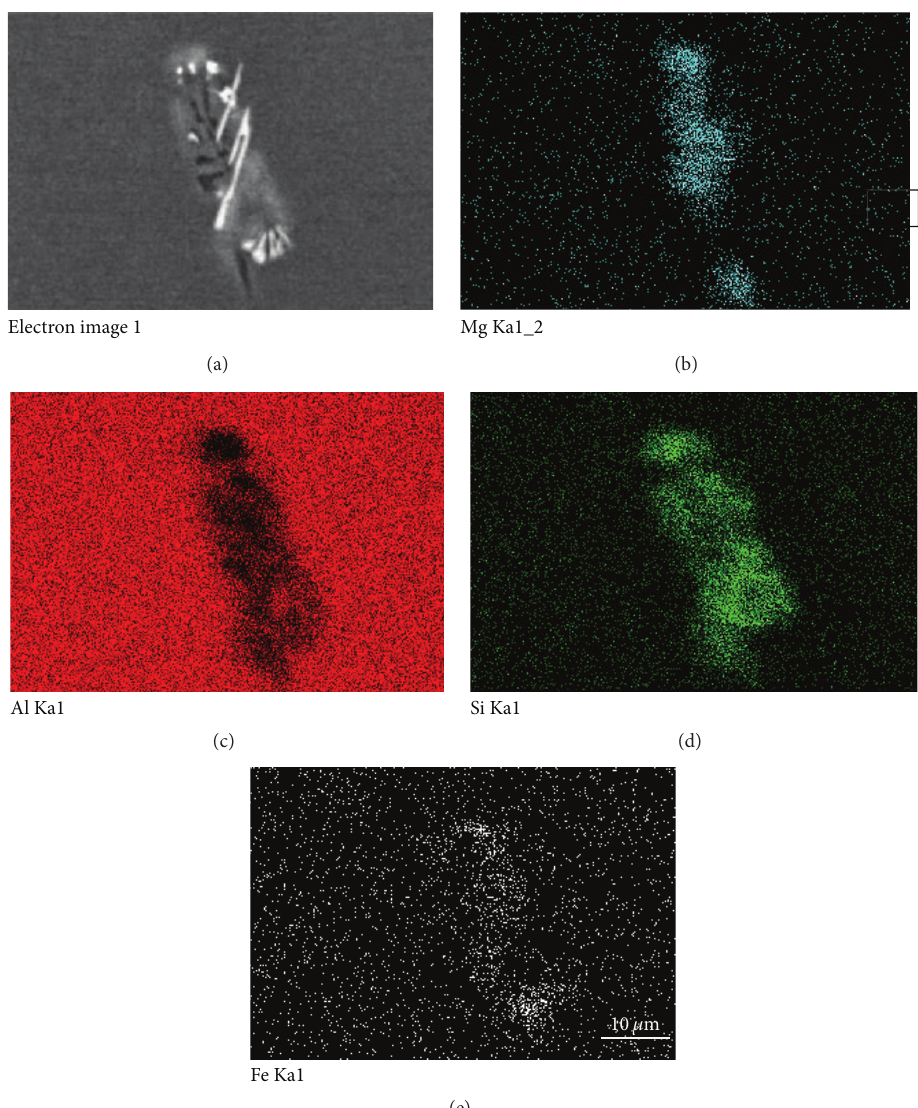
Figure 8: (a) Backscattered image, and images of (b) Mg, (c) Al, (d) Si, and (e) Fe distribution within the new eutectic reaction.